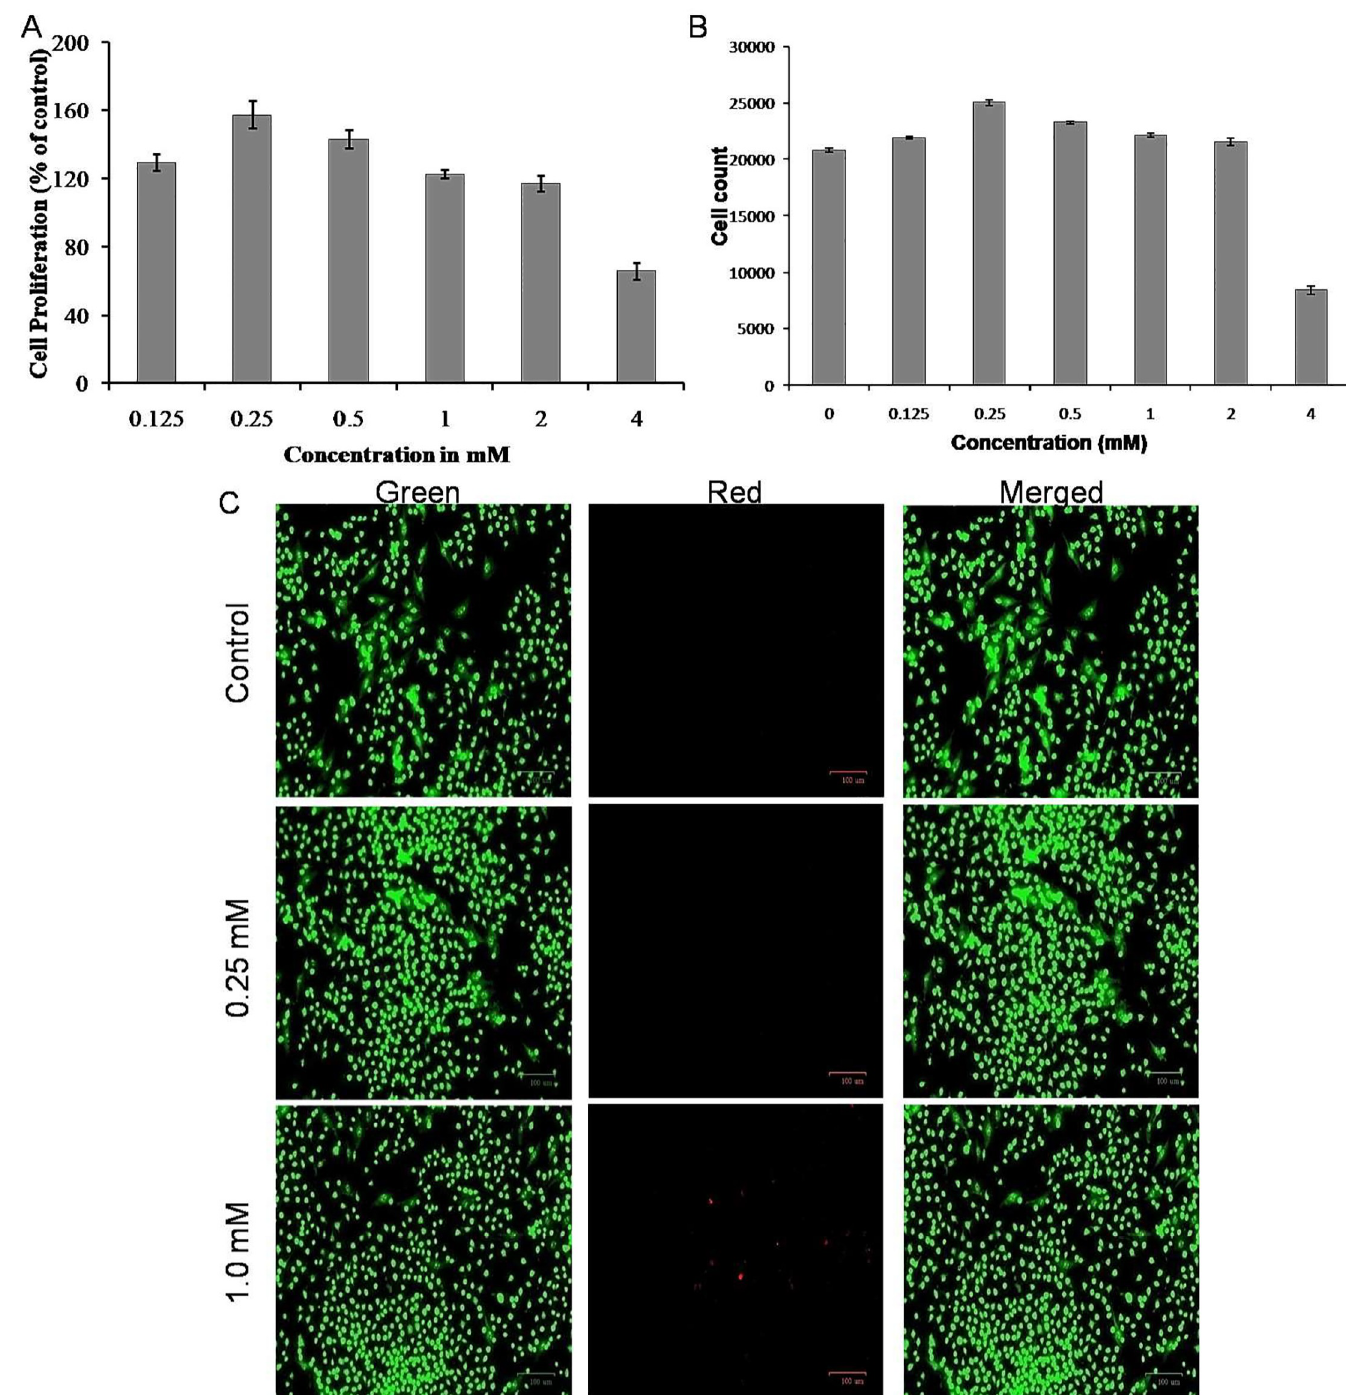
Fig 2. Effect of calcium glucoheptonate on the proliferation of osteoblast-like MG-63 cells. (A) MTT assay. (B) Cell counts from trypan blue dye exclusion assay. Values are mean ± SD (n = 3). (C) Photomicrographs of live/dead stained osteoblast-like MG-63 cells treated with selected concentrations of calcium glucoheptonate in comparison to untreated control. (Scale bar 100 μ m). The green fluorescence represents the nuclei stained with acridine orange indicating viable cells and red fluorescence represent the nuclei stained with ethidium bromide.